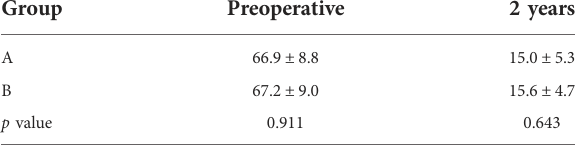
TABLE 4 ODI of two groups